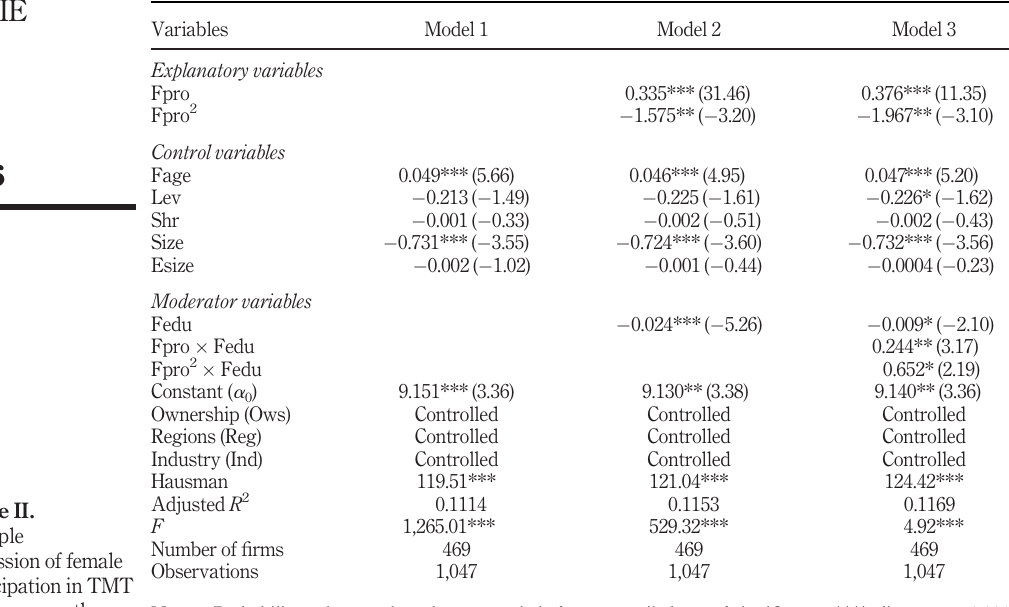
Table II. Multiple regression of female participation in TMT and fi rm growth